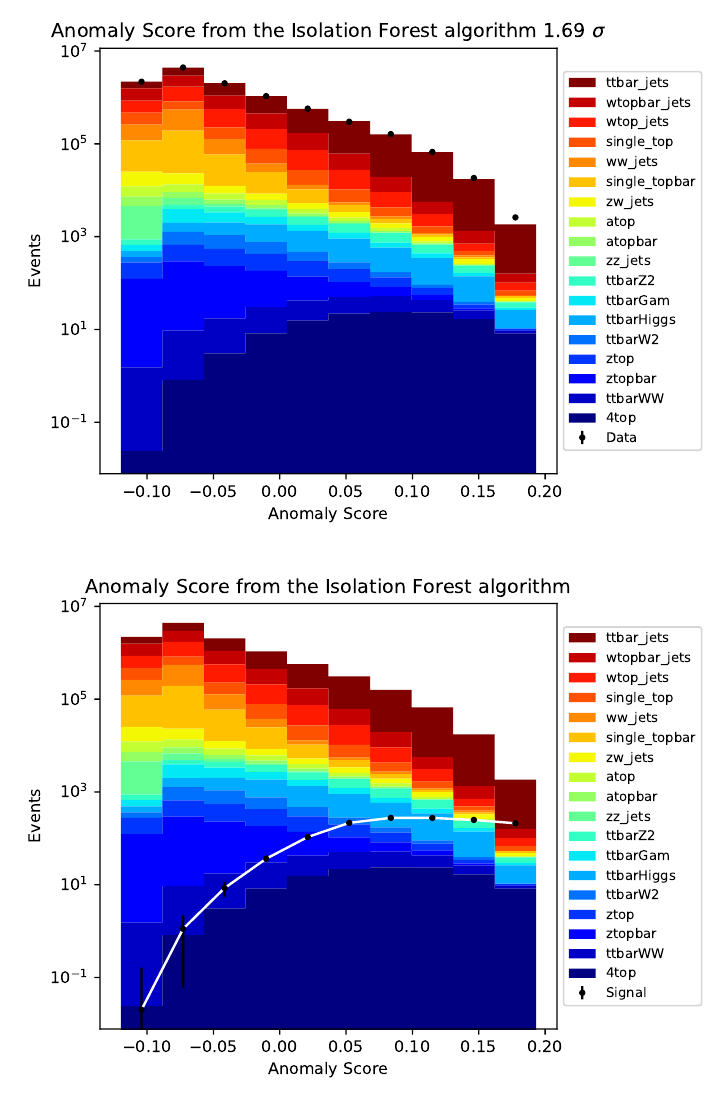
Figure 2. Results from the isolation forest tested on gluino data. On the left is a histogram of back- ground alongside pseudo-data, and on the right is a histogram of background and pure signal. Note that the right-most histogram would not be observed in nature and is purely for